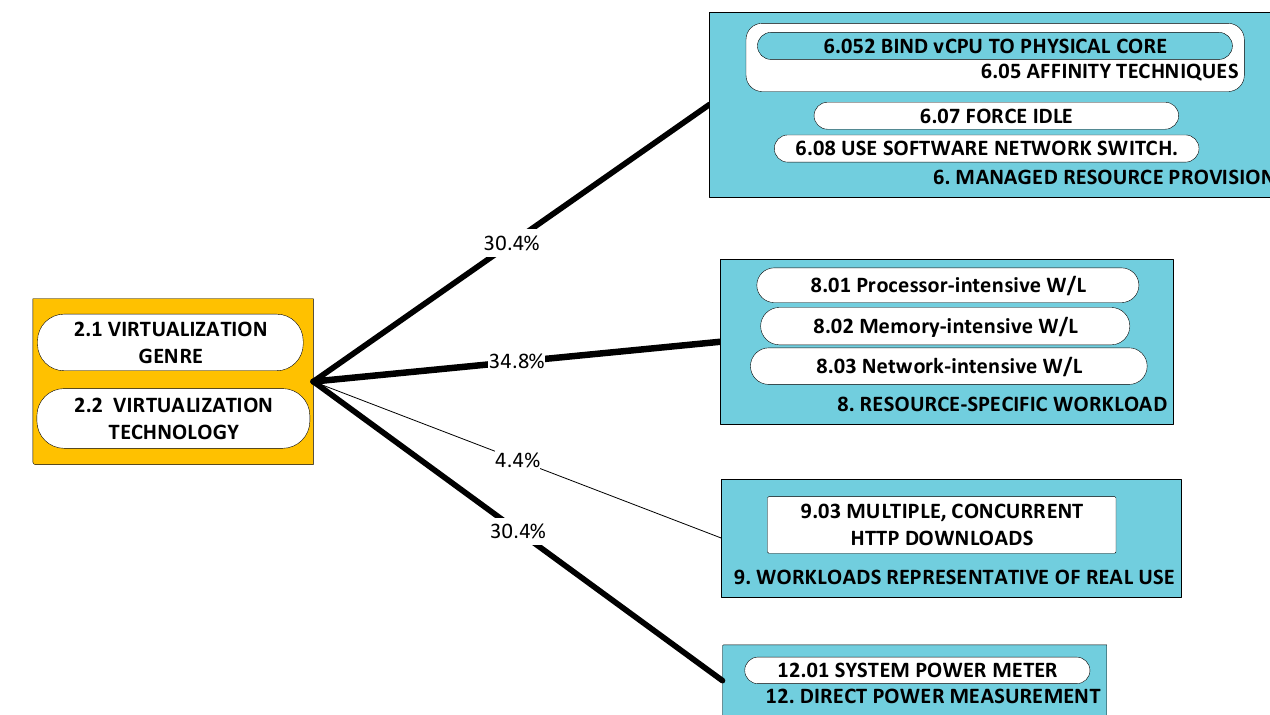
Figure 6. Approaches to solving challenges in category P2; utility metric U A thickness and as a percentage. RUs in the respective categories are the following: P2: [55,56]; A6: [55,56]; A8: [55,56]; A9: [55,56]; A12: [55,56].